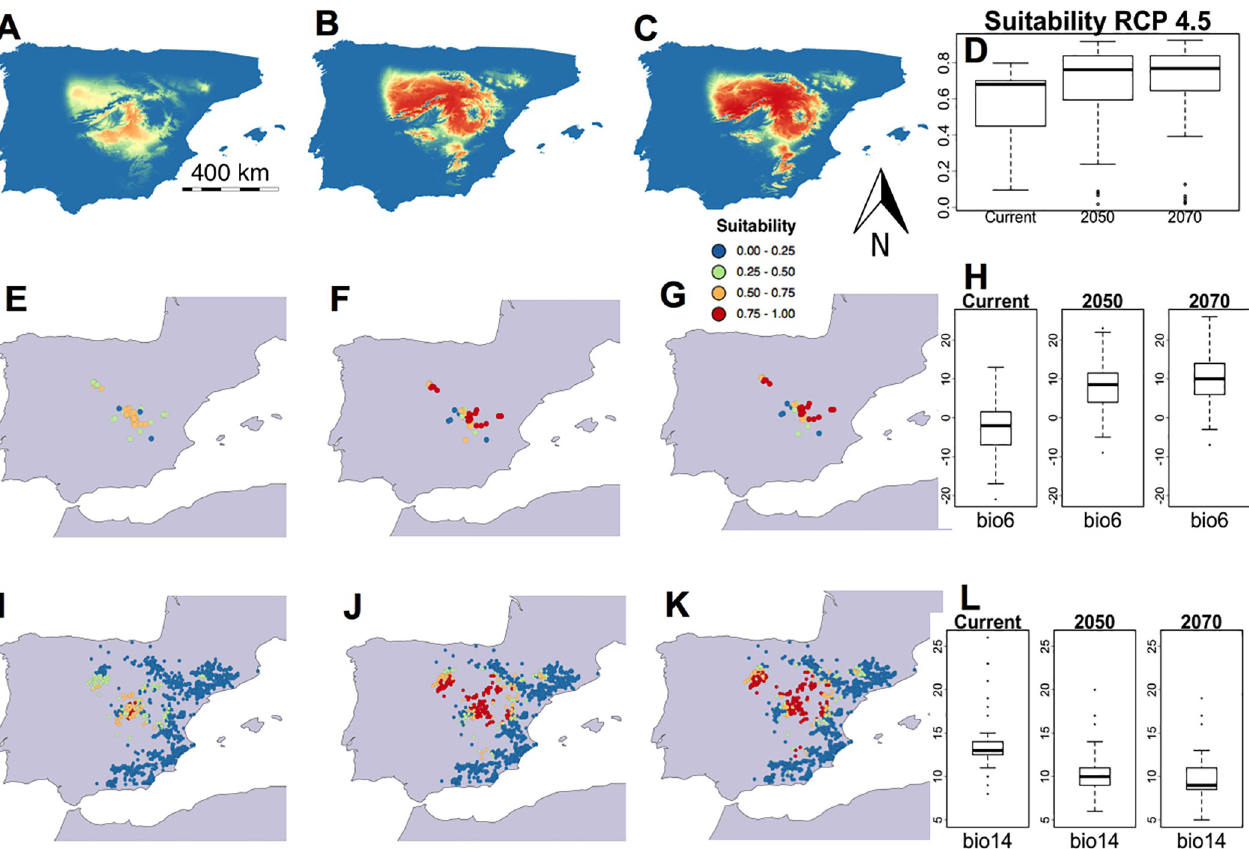
Fig 3. Habitat suitability predicted by the MaxEnt models for G . bermejoi under the RCP 4.5 scenario. Habitat suitability map for the current climatic conditions (A), and those predicted for 2050 (B) and 2070 (C). (D) Habitat suitability values in the current climatic conditions, and under those predicted for 2050 and 2070 (R software standard box-plot), measured at the sites where this taxon is currently found. In E, F and G, we show the bioclimatic suitability at the sites where G . bermejoi occurs at present. In these maps, a color code was used to express the different intervals of habitat suitability. (H) These box-plots show how the Bio 6 variable values evolve (minimum temperature in the coldest month) at the sites where G . bermejoi is currently found. The bioclimatic suitability was also measured at each location with gypsum soil indicated by the presence of O . tridentata . These values are shown for the current climatic conditions, and under the conditions predicted for 2050 and 2070, in maps I, J and K, respectively. (L) These box-plots are similar to those in (H) for the values of the Bio 14 variable (precipitation in the driest month), also measured at the locations where G . bermejoi is currently found.